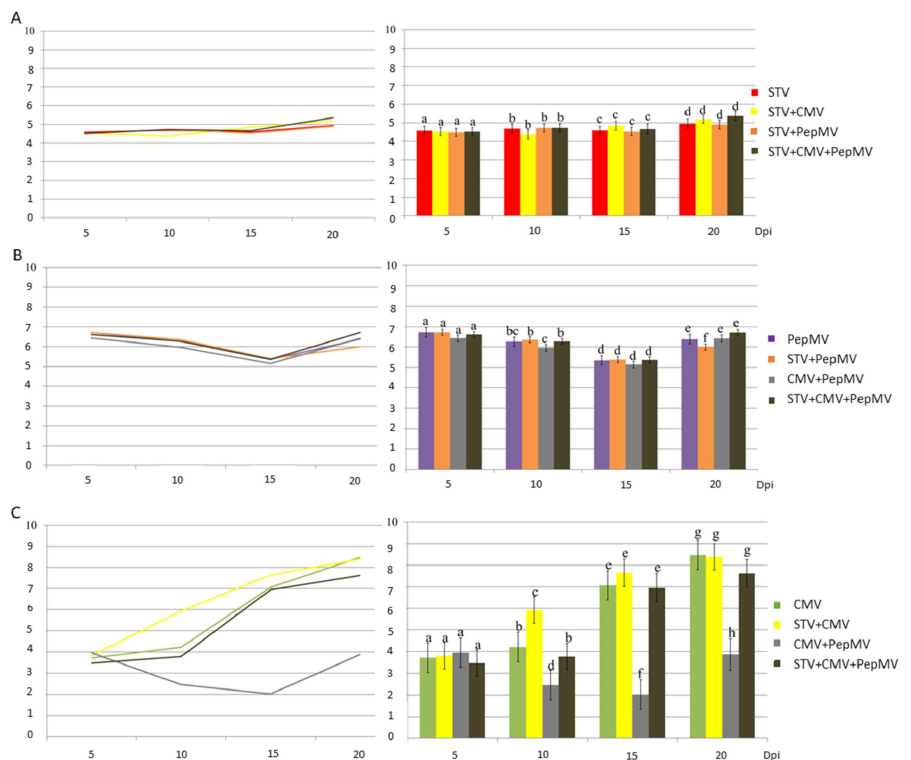
Figure 4. Virus accumulation (mean values) in tomato plants (ordinated axis) shown as log of concen- tration (no. RNA copies/ng of total RNA) of STV, PepMV, and CMV (Panel A , B , C , respectively) in single and mixed infections at 5, 10, 15, and 20 dpi (abscise axis). Bars and letters up to the columns correspond to standard errors and plant groups (in each dpi), respectively, showing differences ( p -value ≤ 0.05). In each panel, virus accumulation is represented by columns ( right ) and in lineal representation ( left